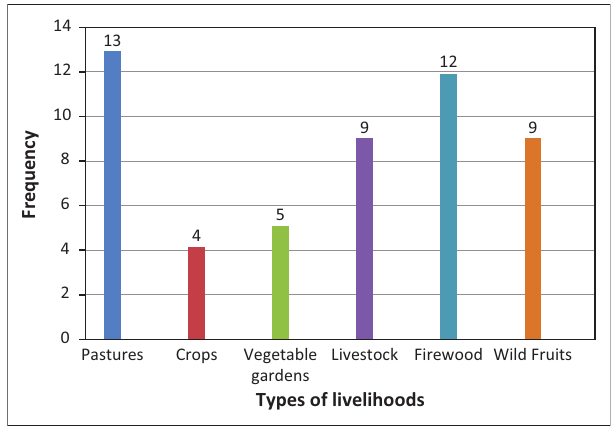
FIGURE 6: Livelihoods most affected by veld fires.